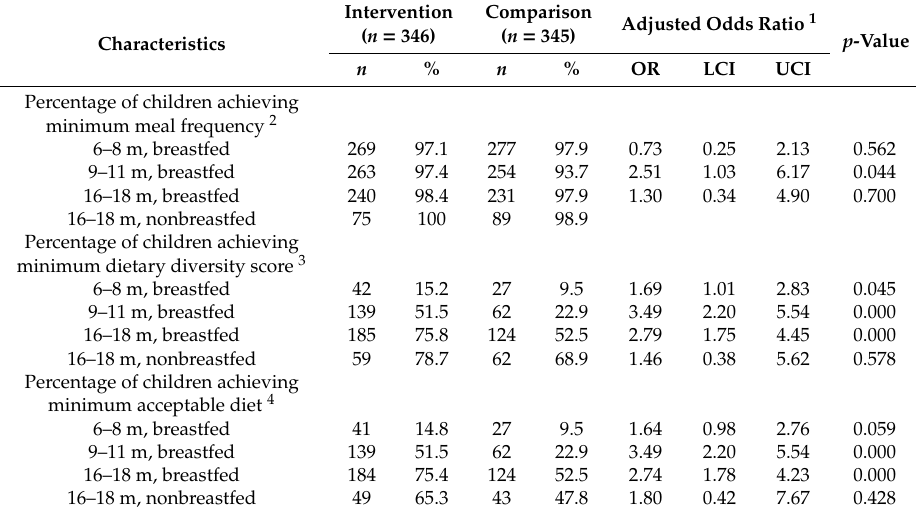
Table 5. Complementary feeding practices, by treatment group.